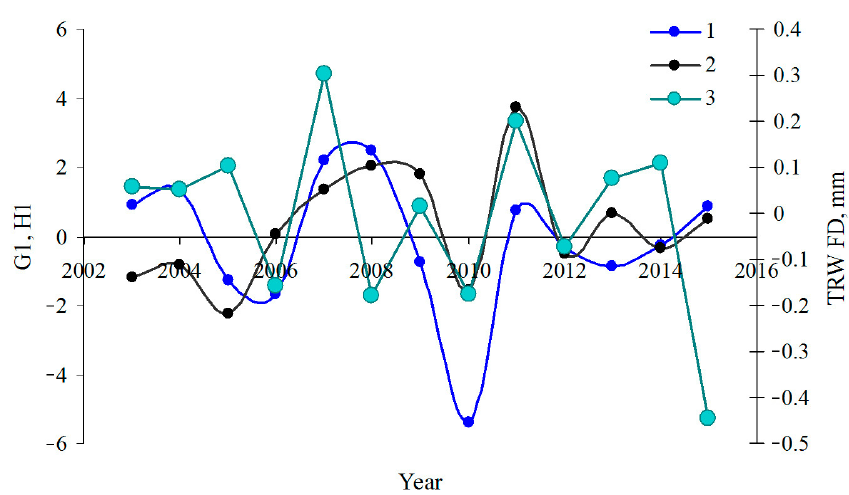
Figure 6. Time series of the first principal components of NDVI G1( t ) (curve 1), the first principal components of LST H1( t ) (curve 2), and the first differences of the radial stem growth time series TRW FD( t ) (curve 3) for sample plot 1.